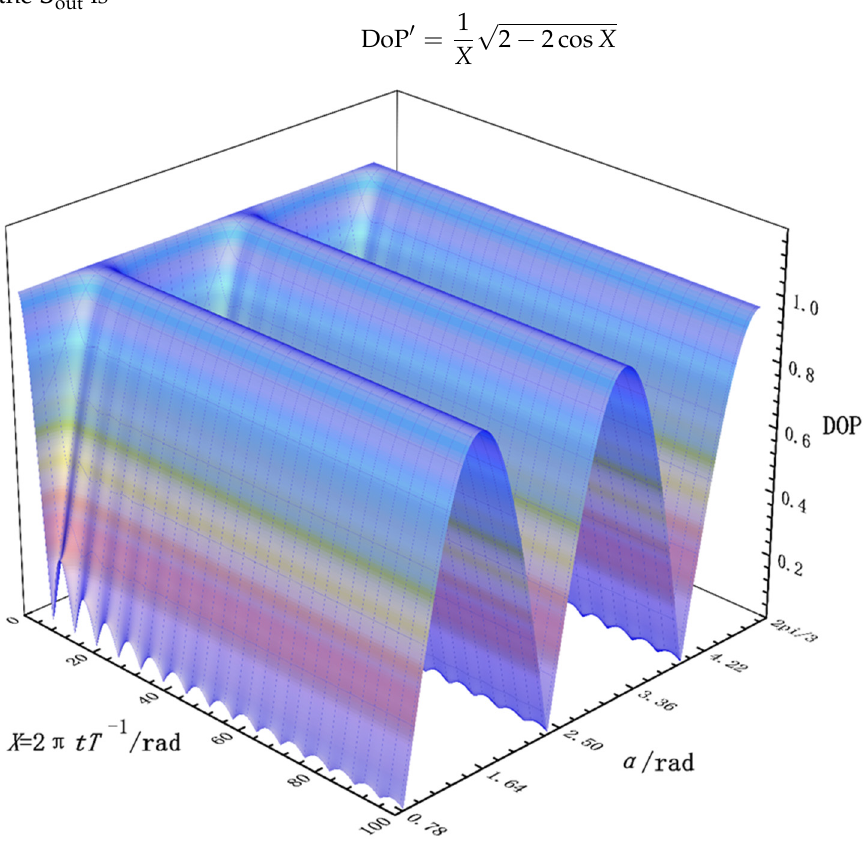
¯ S when the rotation angle =0 θ and incident light is linearly polarized light Figure 3. The DoP of Figure 3. The DoP of S out when the rotation angle θ = 0 and incident light is linearly polarized light out α with polarization direction angle α with polarization direction angle .